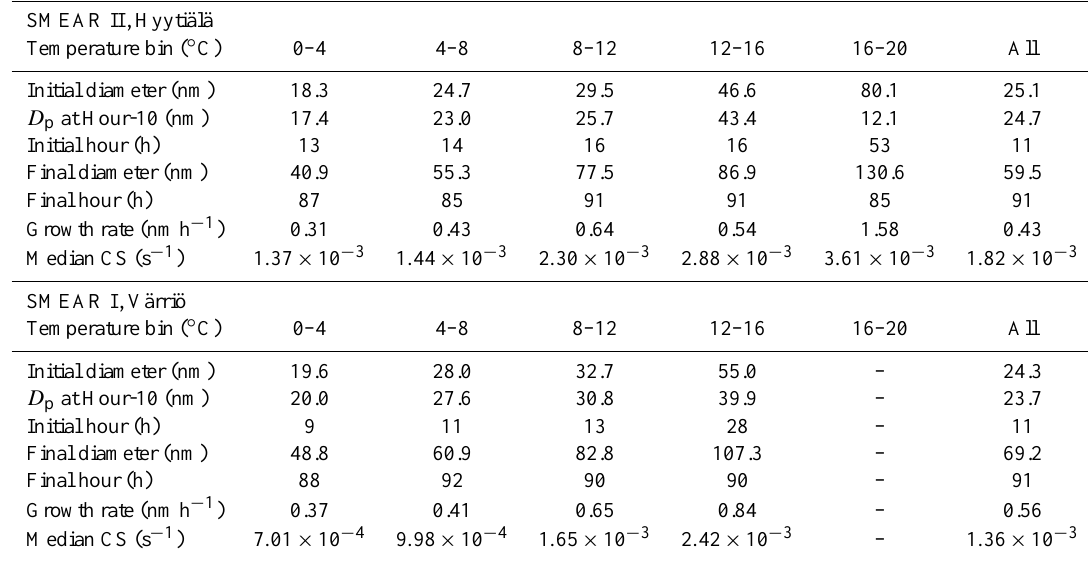
Table 1. Growth rate fitting parameters and condensation sink values in the five temperature bins, as well as from the whole data set both at the SMEAR I and the SMEAR II